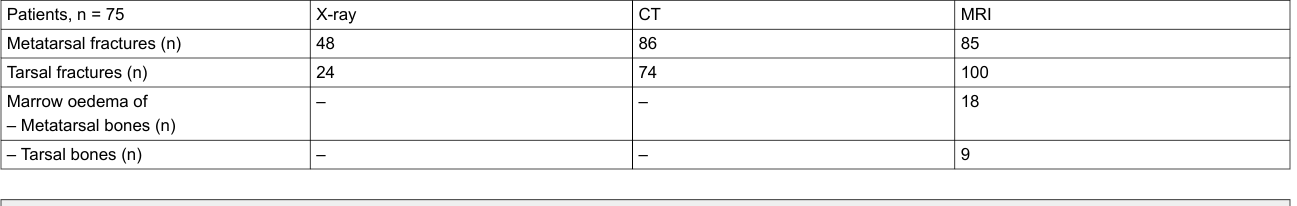
Table 2: Grading of bone stress injury, according to MRI findings. Adapted from Kiuru et al. [16, 17]. Grade I Endosteal marrow oedema (X-ray